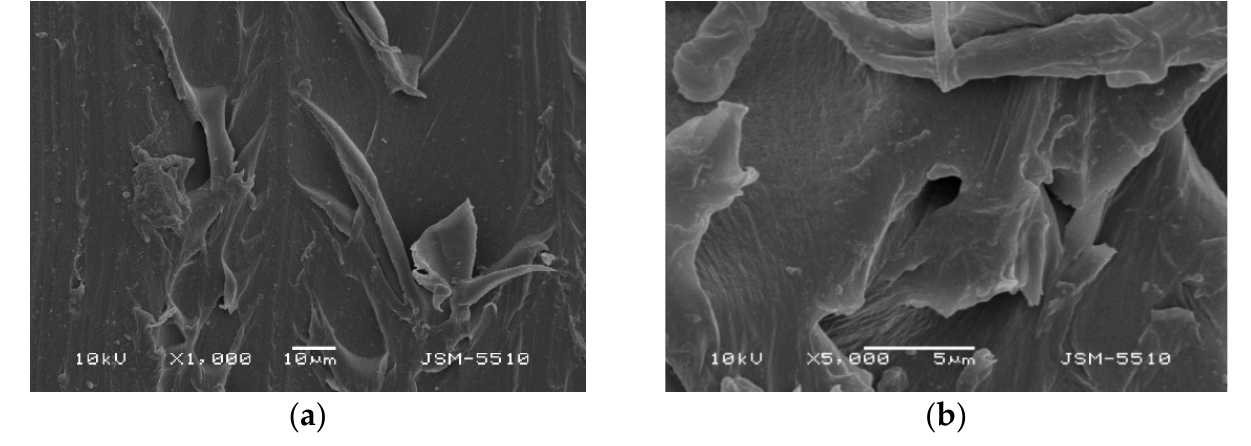
Figure 4. ( a ) TS under magnification ×1000. ( b ) TS under magnification ×5000.